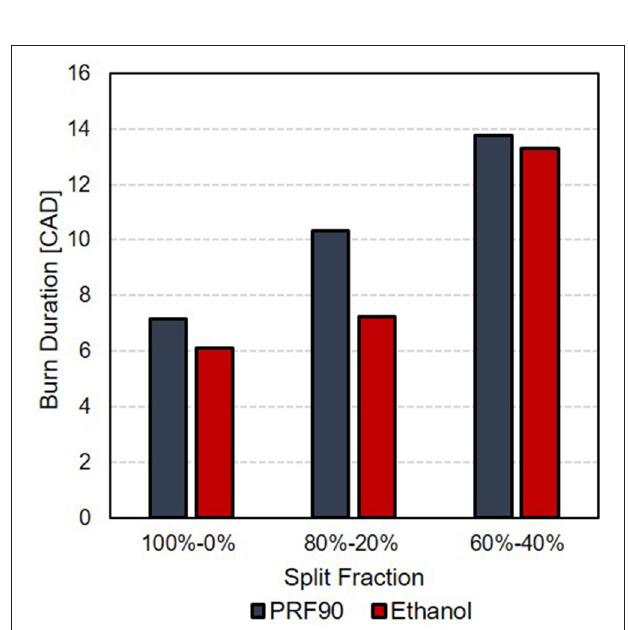
100–0% case to 10.3 ◦ and 13.7 ◦ CAD for the 80–20 and